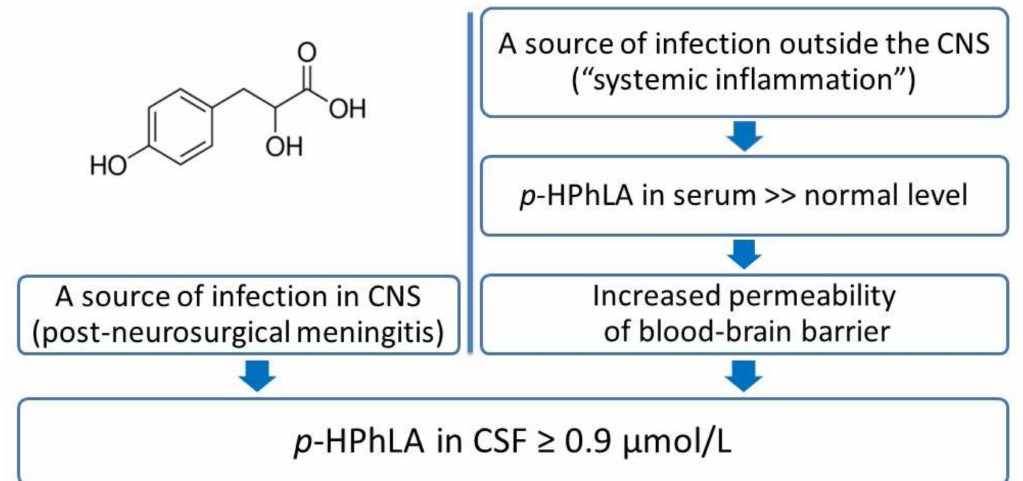
Figure 3. The potential infectious sources of increased p -HPhLA levels in CSF of post- neurosurgical